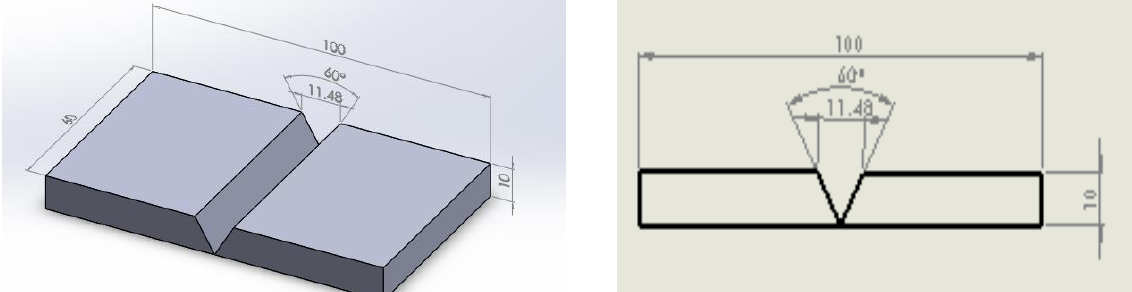
Figure 1: Dimensions of the sample used in welding process